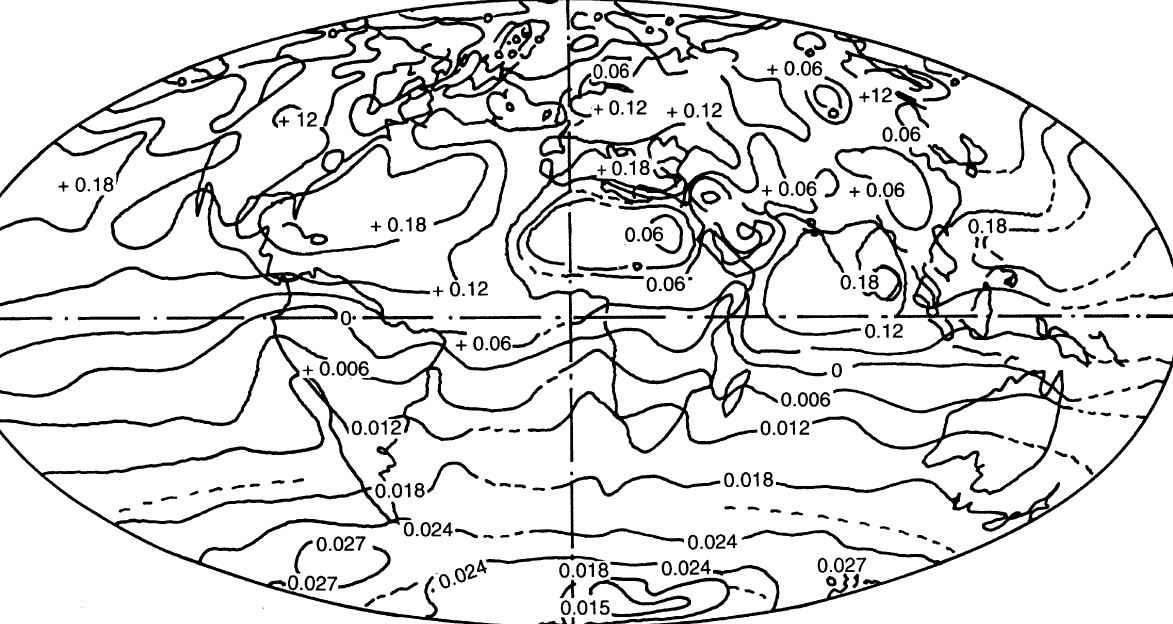
Fig. 1. Radiation balance of the Earth-atmosphere system for July over the entire path (after Raschke et al ., 1967). The figure indicates